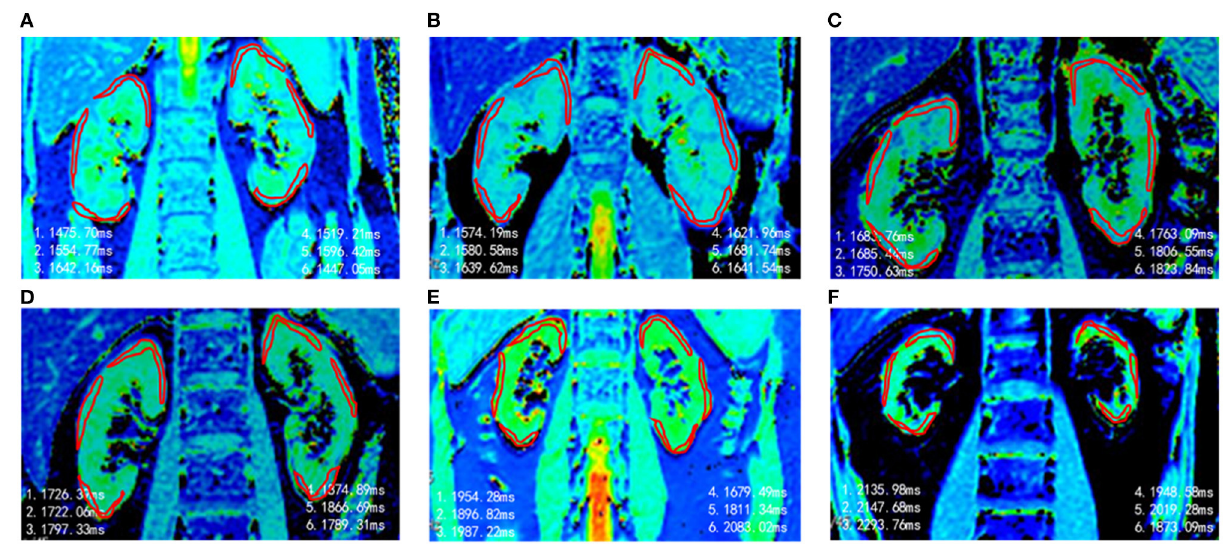
Frontiers in Medicine |